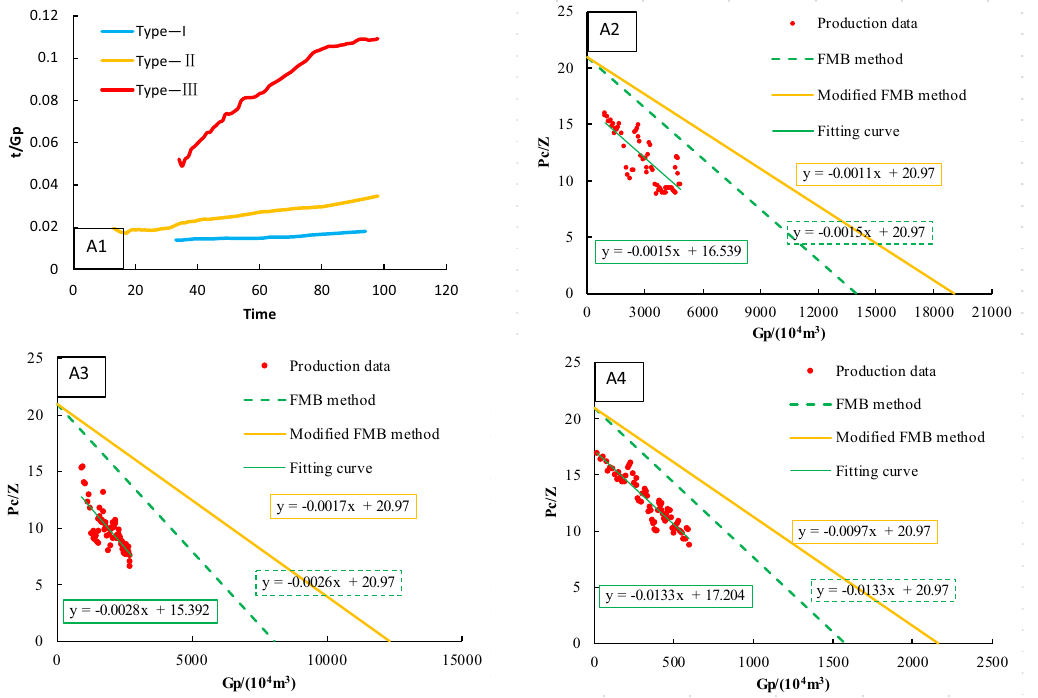
Fig. 15 Calculation results of dynamic reserves by modified FMB method (A1: decline characteristic; A2: Type-I wells; A3: Type-II wells; A4: Type-III